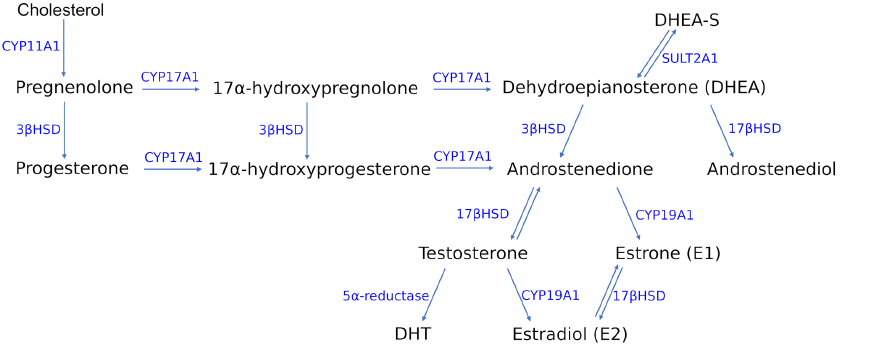
Figure 2. Adipose tissue is an important side for sex hormone interconversions. This figure summa- rizes the most prominent reactions of this kind. All sex hormones can be synthesized de novo from cholesterol in presence of active steroid hormones. However, more frequently in adipose tissue, the hormones are taken up from plasma and further transformed into other ones. The direction and effi- ciency within the steroid biosynthetic pathways in adipose tissue depends on the relative expression and activity of steroidogenic enzymes, which are gender-, age- and depot-specific. Abbreviations: CYP11A1, cholesterol side-chain cleavage enzyme; CYP17A1, steroid 17 α -monooxygenase; 3 β -HSD, 3 β -hydroxysteroid dehydrogenase; 17 β -HSD, 17 β -hydroxysteroid dehydrogenase; SULT2A1, dehy- droepiandrosterone sulfotransferase; DHT,